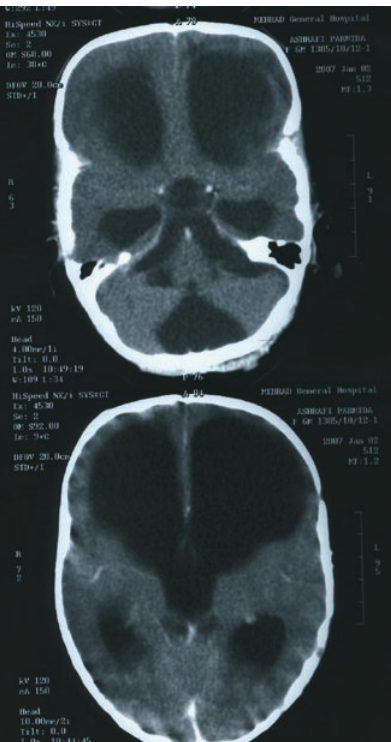
Figure 2. Brain CT scan of the infant showing ventricular